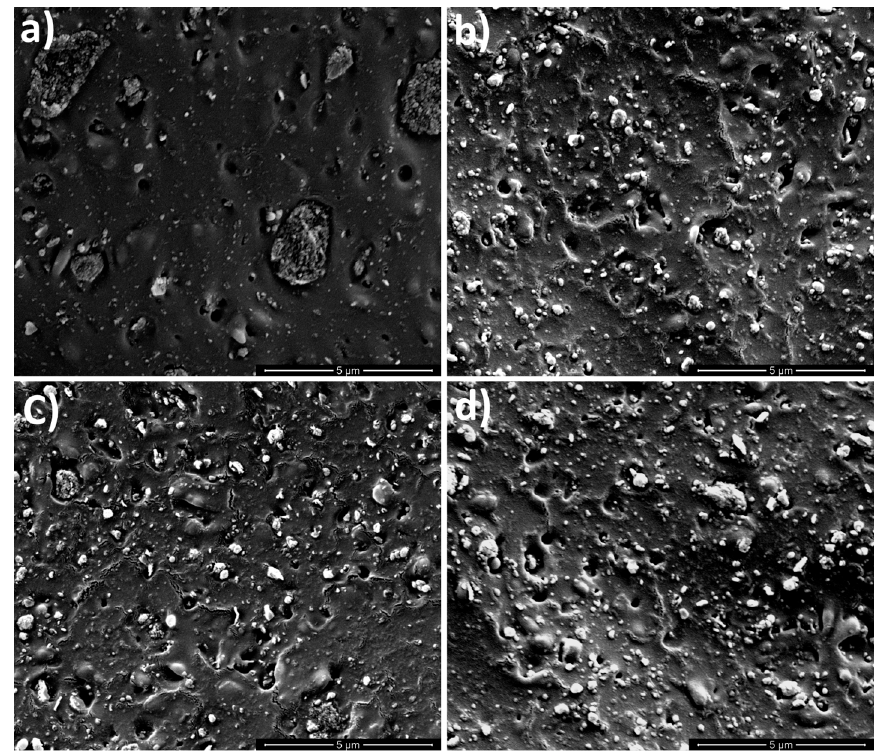
Figure 3. SEM micrograph of ( a ) poly(lactic acid) (PLA) + GnP R0; ( b ) PLA + GnP R1; ( c ) PLA + GnP R3; ( d )PLA+ GnP R5.